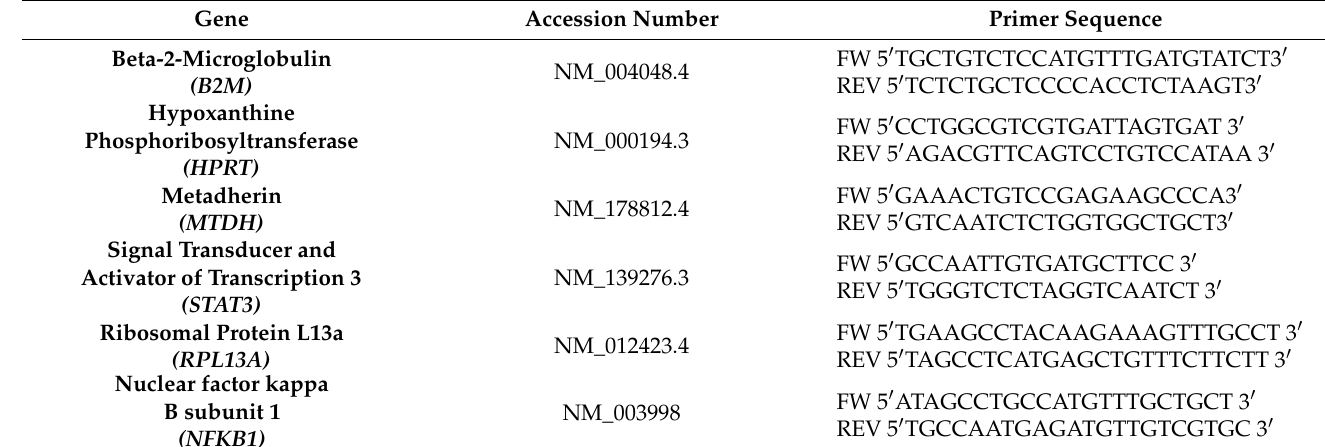
Table 1. List of the genes and primers used in the RT-qPCR